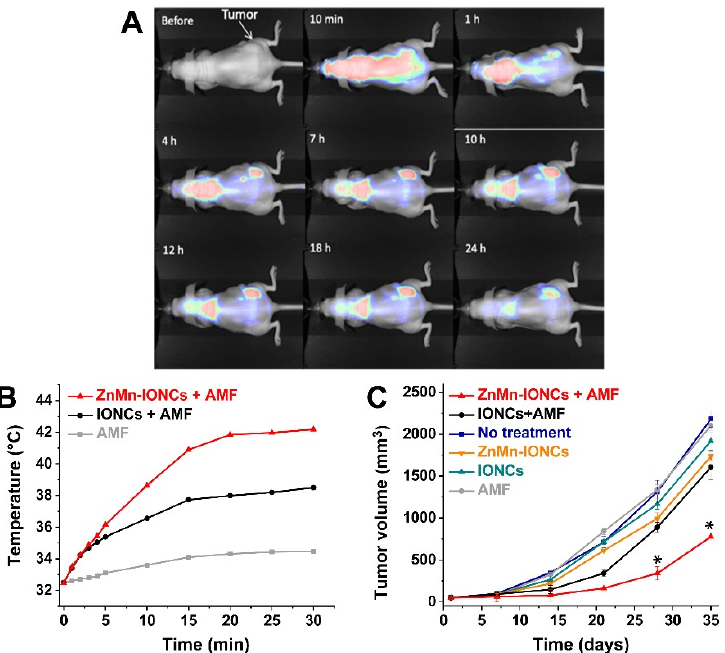
Figure 1. ( A ) NIR fluorescence images of a mouse at different time points following intravenous administration of the Mn-Zn magnetic cluster. ( B , C ) Intratumoral temperature curves during AFM and corresponding tumor growth profiles for each experimental group. Adapted with permission from [47], MDPI, 2020.